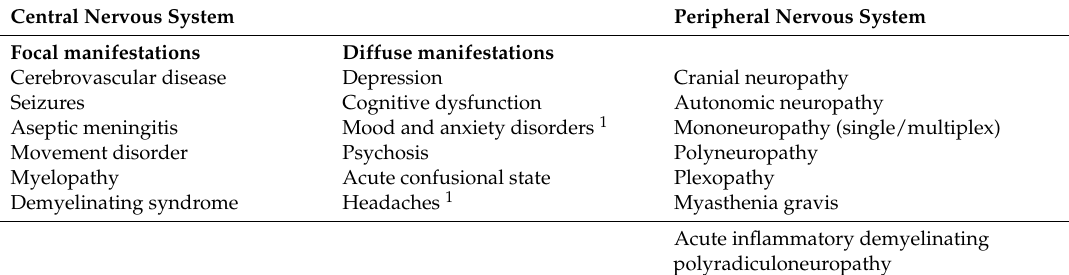
Table 1. ACR case classification of the NP manifestations described in SLE